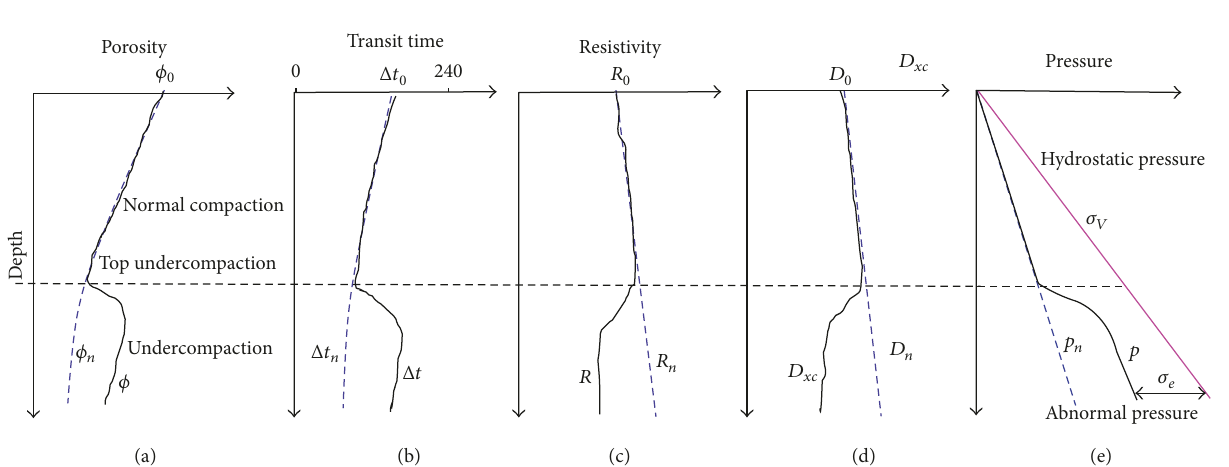
Figure 11: Generalized normal compaction trends (NCTs) and abnormal pressures caused by undercompaction. From (a) to (e): porosity, transit time, resistivity, 𝐷 -exponent, and pore pressure